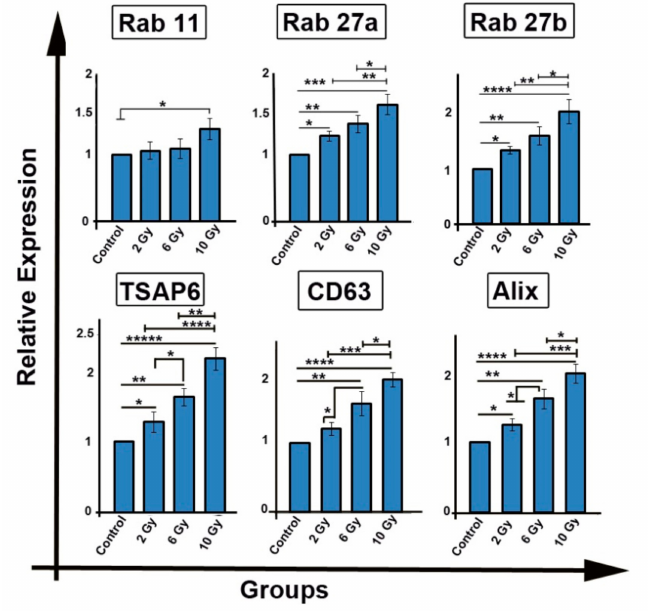
Figure 3. The mRNA levels of genes involved in exosome biogenesis and secretion including Rab11, Rab27a, Rab27b, TSPA6, CD63, and Alix was investigated by qPCR. One-way ANOVA with Tukey test was applied. All values are means ± SD; n = 3. * p < 0.05, * * p < 0.01, *** p < 0.001, **** p < 0.0001, ***** p <